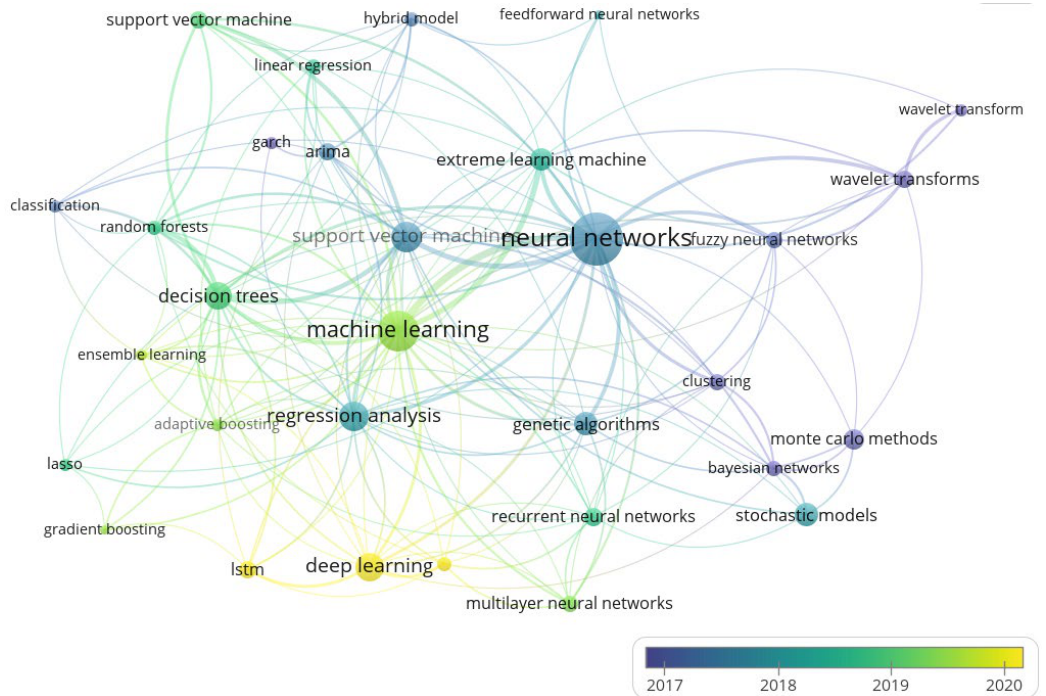
Figure 6. Bibliometric map of keywords in the overlay visualization context, co-occurrences (minimum 5) results from Scopus based on Query 1. Source: Authors’ elaboration performed in the VOSviewer (version